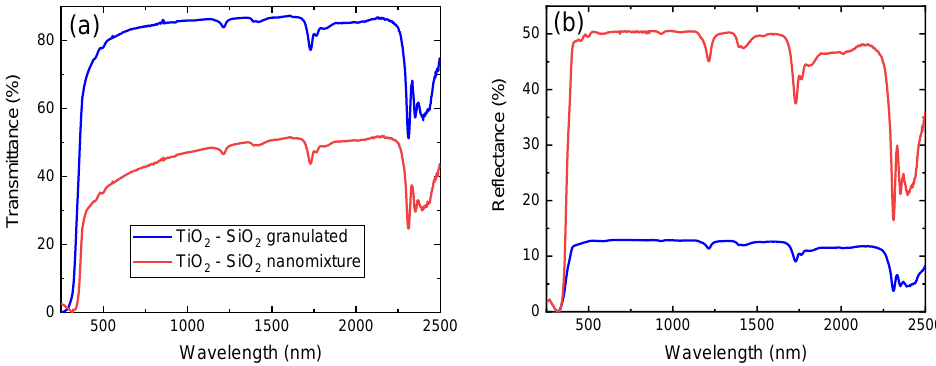
Figure 4. ( a ) Transmittance and ( b ) reflectance of TiO 2 - SiO 2 nanoparticles of nanomixed (red) and granulated (blue) nature embedded in low-density polyethylene (LDPE) from 250 nm to 2500